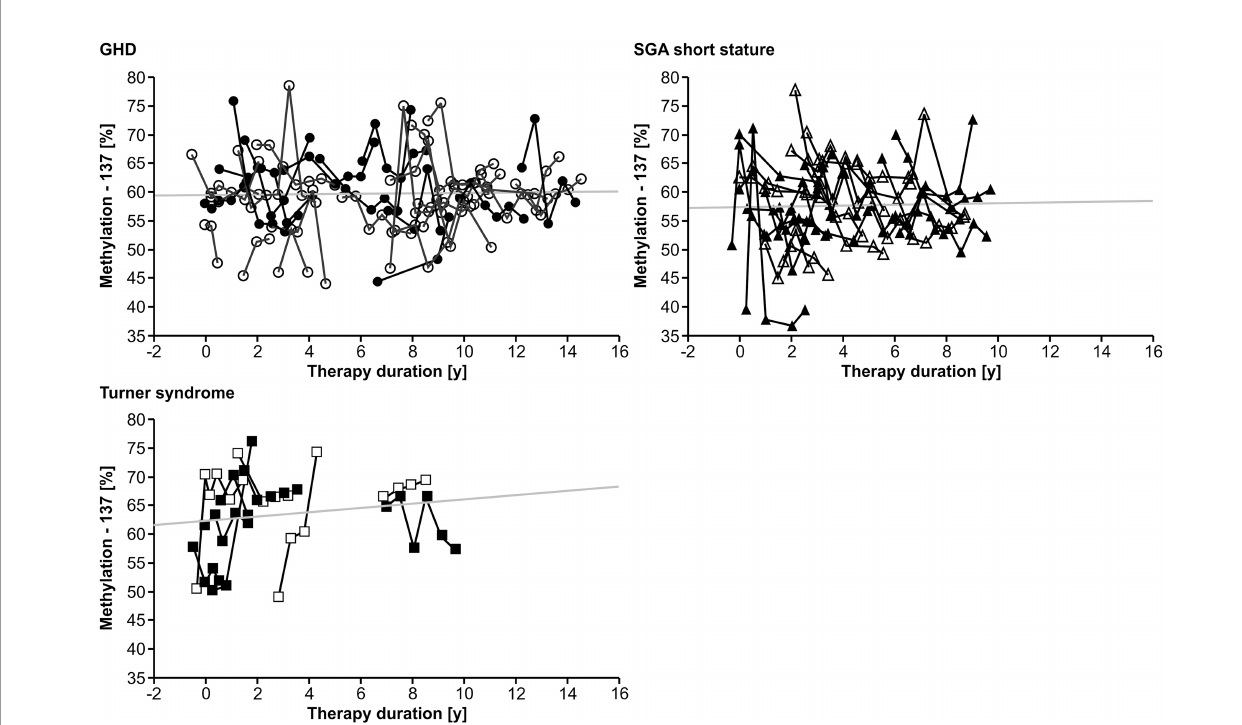
FIGURE 1 | Longitudinal course of IGF1 P2 methylation at position -137 in blood of children with GHD, SGA short stature and Turner syndrome treated with rhGH. Filled symbols indicate patients with exon3-deleted GHR.